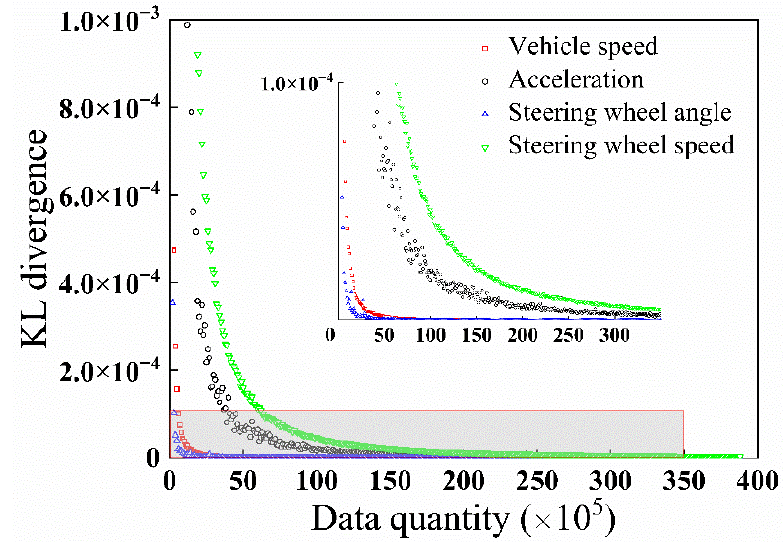
Figure 5. The KL of different parameters versus data quantity.